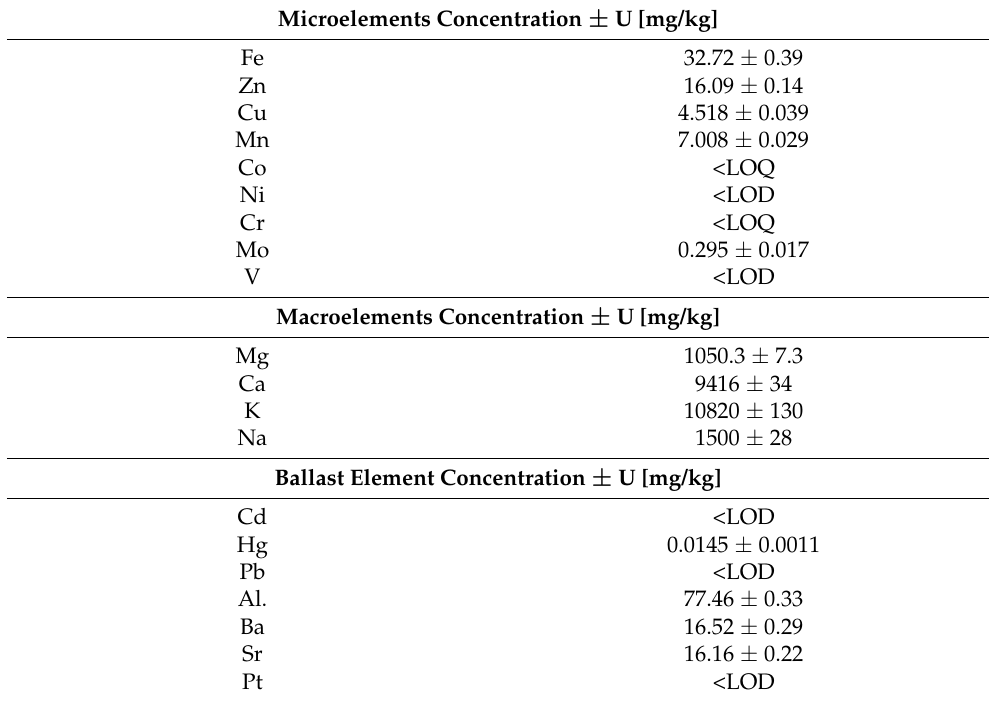
Table 6. Results of the determination of the content of selected elements in kaffir lime peel (x m ± U, (k =